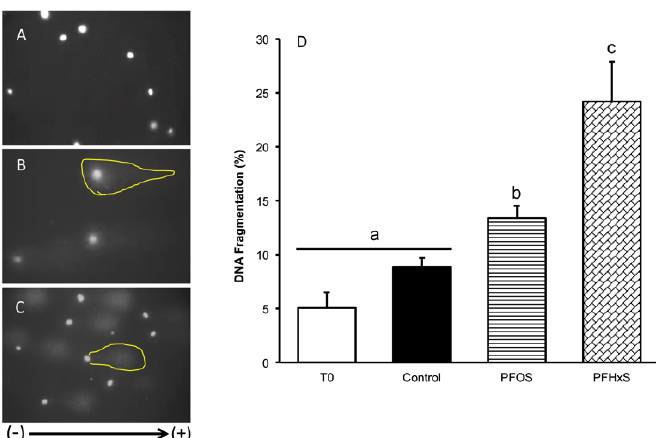
Figure 9. Determination of DNA fragmentation by comet assay, n = 4. ( A ) Sample in T0 with low level of fragmentation. ( B ) Sample with medium level of fragmentation after exposure to PFOS, and ( C ) Sample with high level of fragmentation due to exposure to PFHxS. The arrow indicates the direction of migration of DNA fragments to the positive pole, allowing the formation of the comet, the ethidium bromide allows the observation by fluorescence microscopy, yellow line indicates the tail comet area. The graph in ( D ) shows a significant increase in DNA fragmentation, about five and three times, after exposure to PFHxS and PFOS respectively compared to T0. No significant di ff erences between T0 and the Control were detected. a, b, c Di ff erent lowercase letters indicate the existence of significant di ff erences between treatments ( p < 0.05).